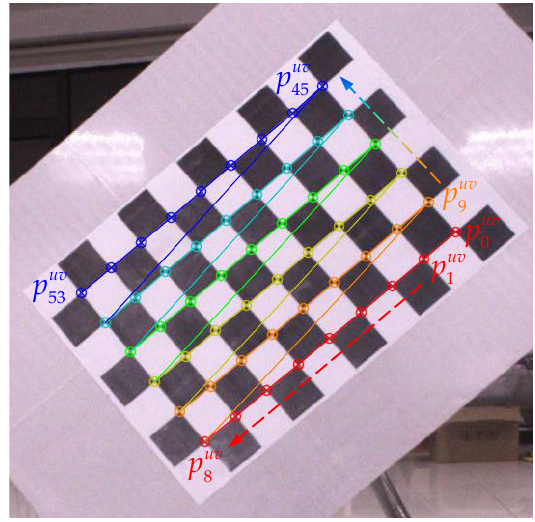
Figure 5. Subpixel checkerboard corner detection.